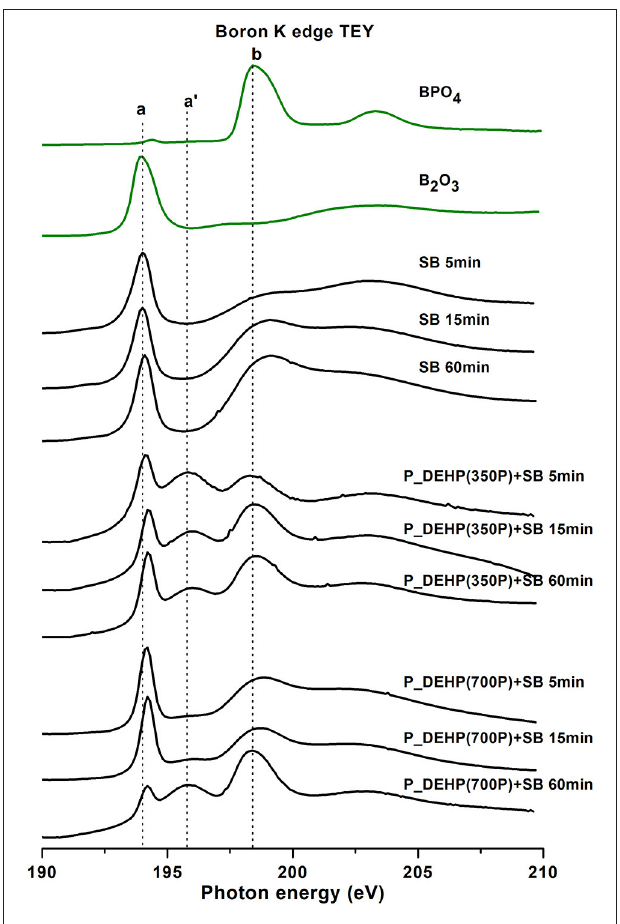
FIGURE 10 | Boron K-edge TEY spectra of tribofilms (black lines) derived at 5, 15, and 60min test for SB, P_DEHP(350P) + SB, and P_DEHP(700P) + SB lubrication along with model compounds (green lines).